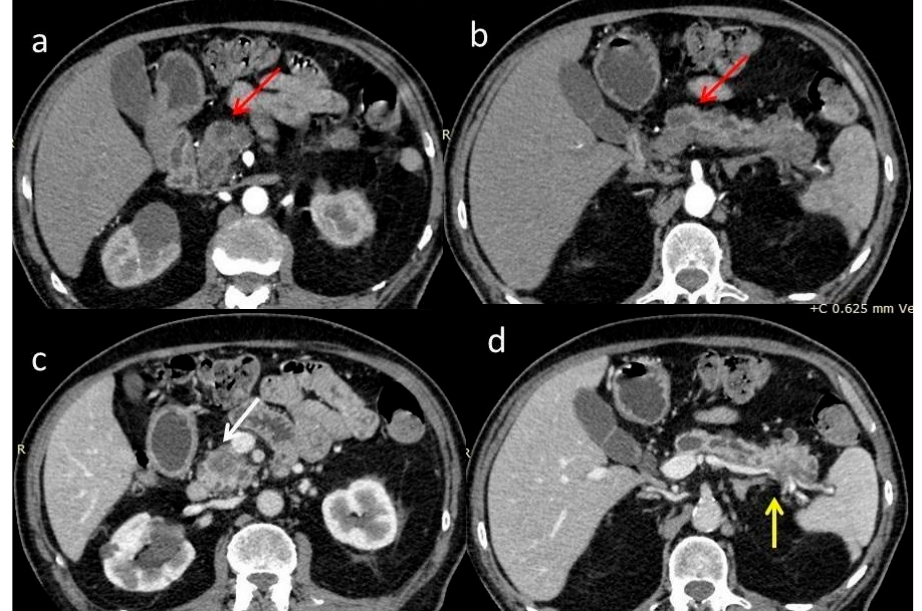
Figure 2. ( a , b ) arterial phase and ( c , d ) venous phase of a contrast-enhanced computed tomography scan (CECT). Poorly enhanced masses at the head and tail (red arrows) of the pancreas with sur- rounding fat stranding. The mass at the head of the pancreas occludes the pancreatic duct, causing peripheral dilatation (white arrow). Limited contact with the posterior surface of the superior mes- enteric vein <90°. The mass of the tail invades the splenic vein (yellow arrow). Abnormal dilatation of the main pancreatic duct with strictures is demonstrated with multiple collateral cystic lesions. Endoscopic ultrasound of the pancreas showed hypoechoic masses in the head and tail measuring 2.2 cm × 2.5 cm and 2.5 cm × 2.8 cm, respectively. We performed an endoscopic ultrasound-guided fine needle biopsy (EUS-FNB), and the cytological analysis revealed moderately differentiated PDAC in specimens from both the head and tail of the pancreas.